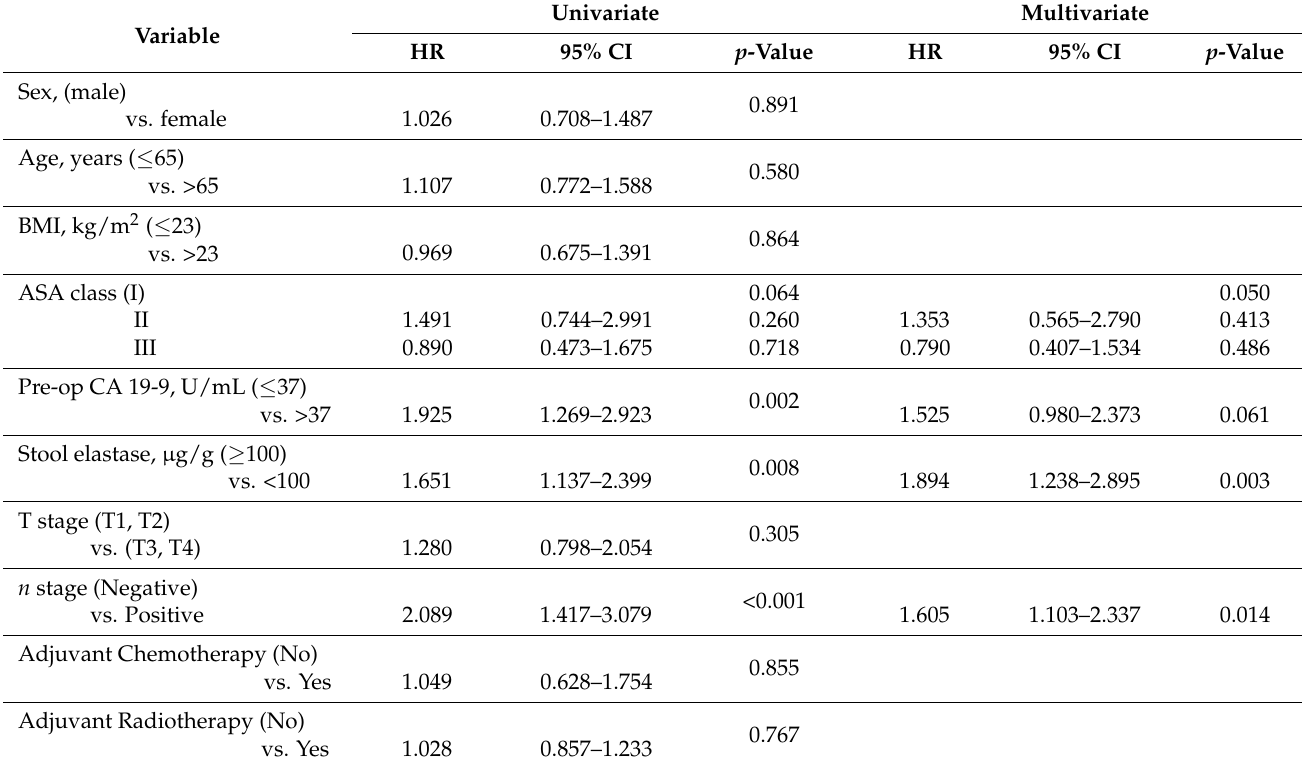
Table 3. Univariate and multivariate analysis of risk factors for disease-free